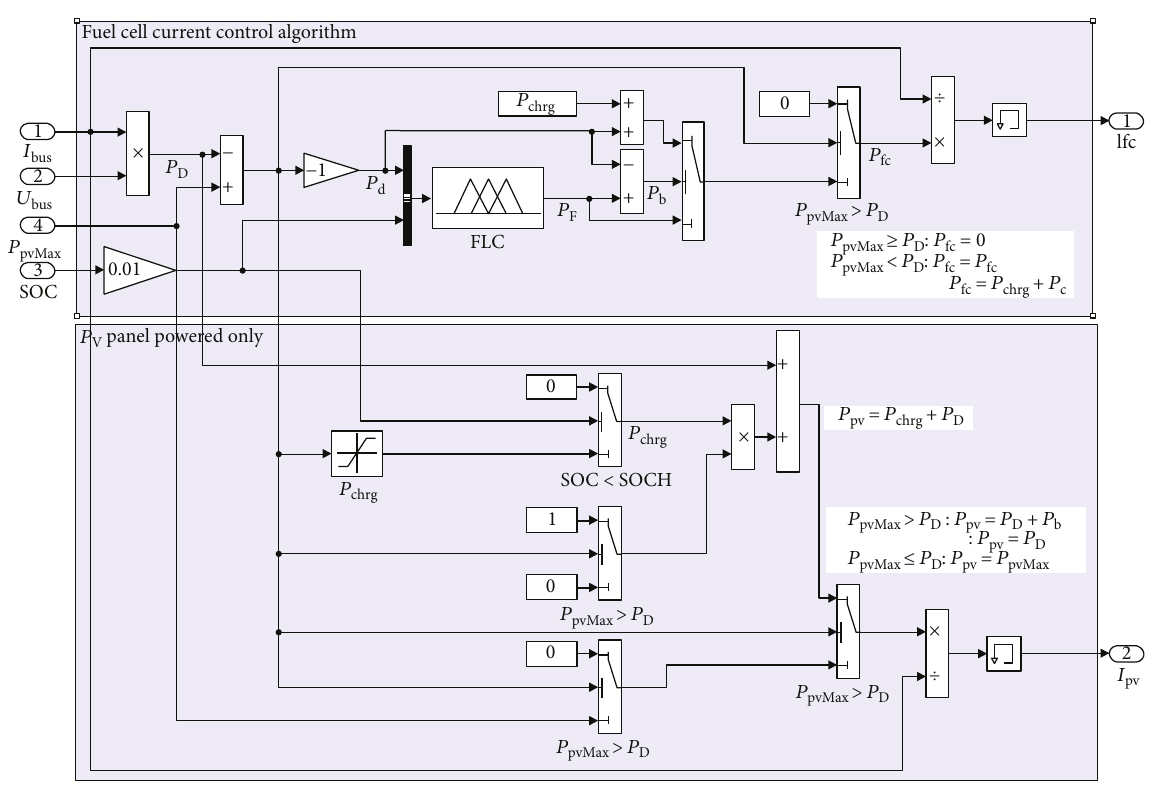
Figure 4: Topology of ECU simulation